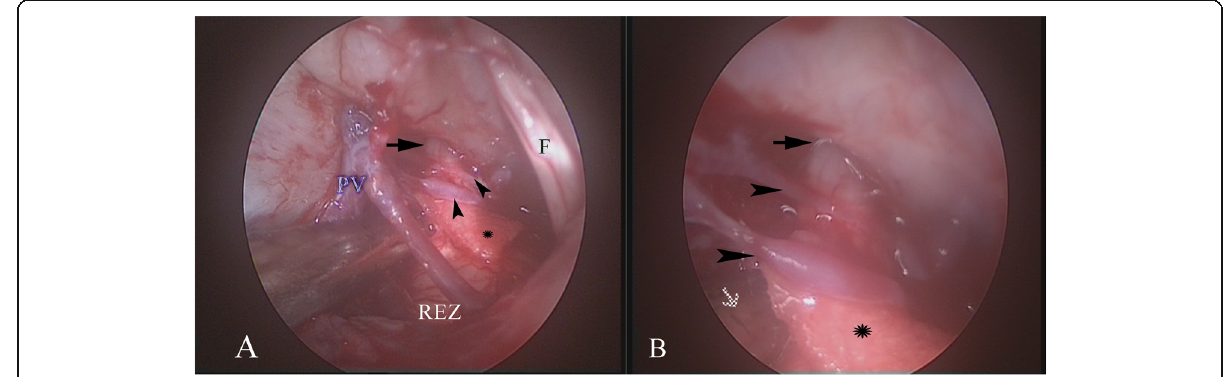
Fig. 2 Endoscopic view of MVD for trigeminal neuralgia (right side). a PV., petrosal vein. REZ., root entry zone. Arrowheads point to vascular compression separated by a piece of Teflon. F., facial nerve. Arrow points to the entry of the trigeminal nerve into the Meckel ’ s cave. b Close up view, arrow points to the entry of the trigeminal nerve into the Meckel ’ s cave. Arrowheads point to the vascular compression. Asterix , Teflon piece. White arrow brain